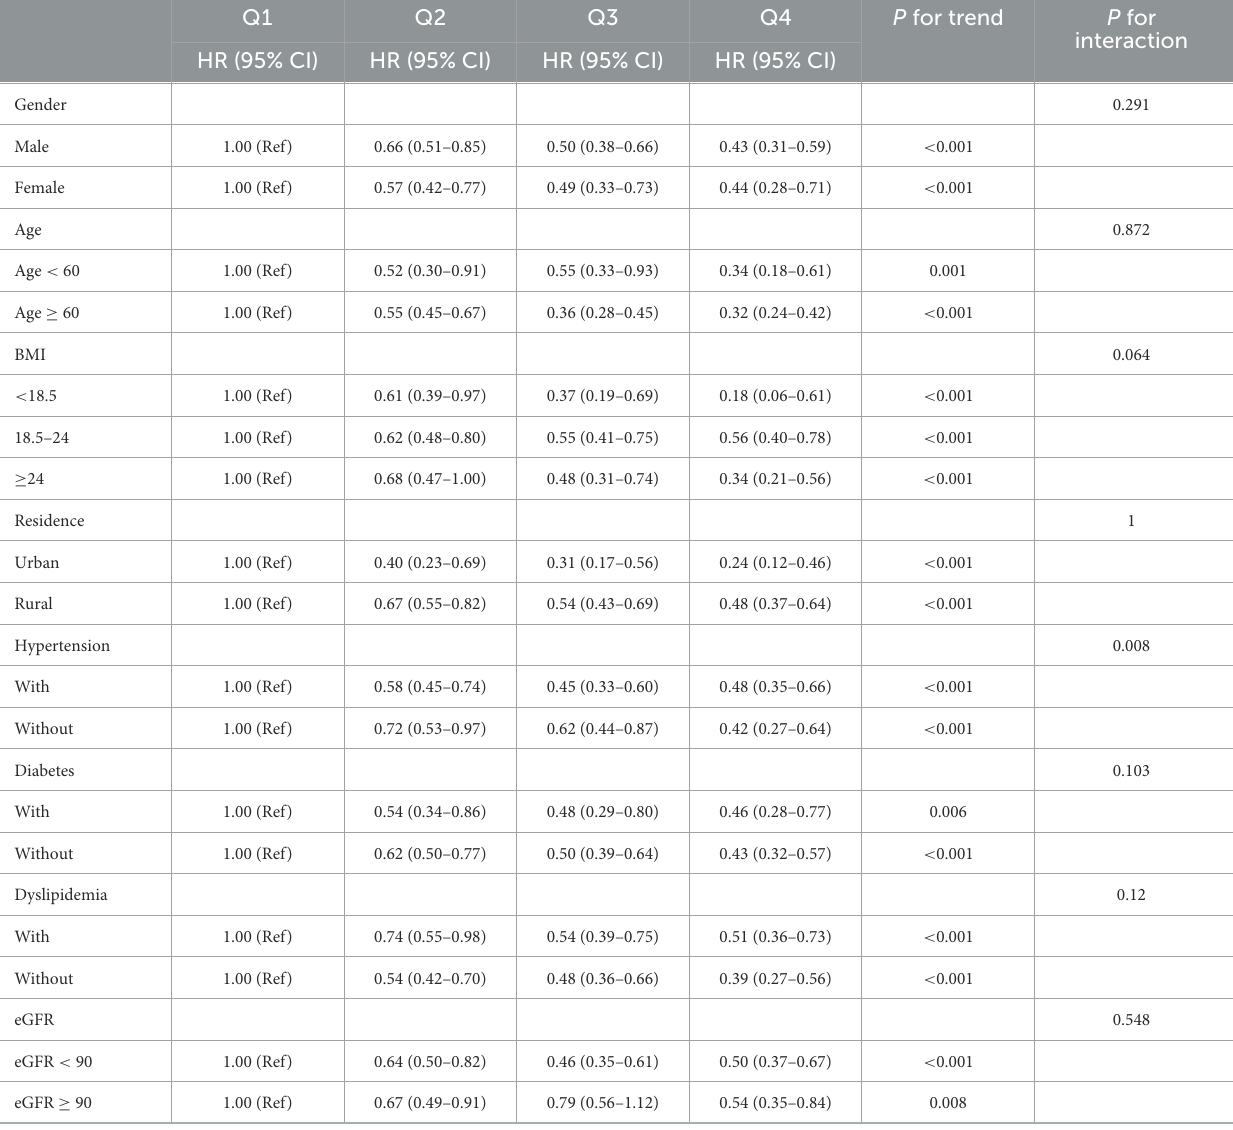
TABLE 4 Subgroup analysis of HRs (95% CIs) of SI for all-cause